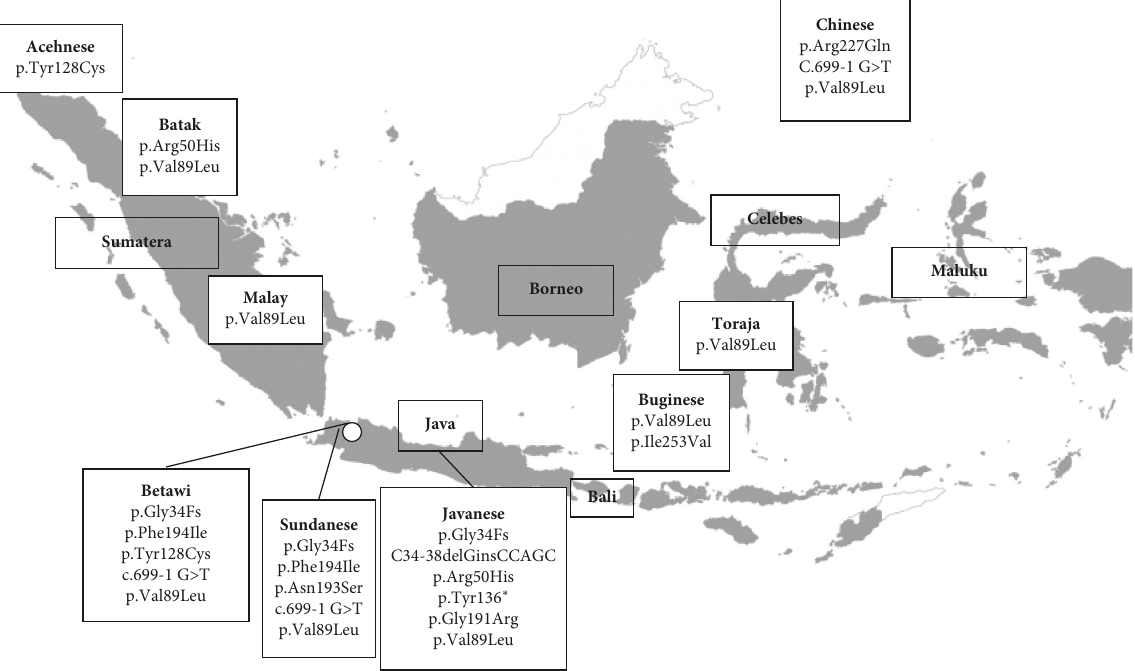
Figure 2: The geographical distribution of the identified SRD5A2 gene variants as determined by the ancestral place of origin for each participant. Transparent boxes indicate major islands in Indonesia; white boxes indicate SRD5A2 gene variations based on subjects’ ethnic origins. Acehnese, Batak, and Malay are originated from Sumatera island; the Sundanese, Betawi, and Javanese reside in Java island; and Buginese and Toraja are from South Celebes. The Indonesian Chinese people reside in almost all of Indonesian islands, especially in the major islands. White dot ( ◦ ) indicates Jakarta, the capital city of